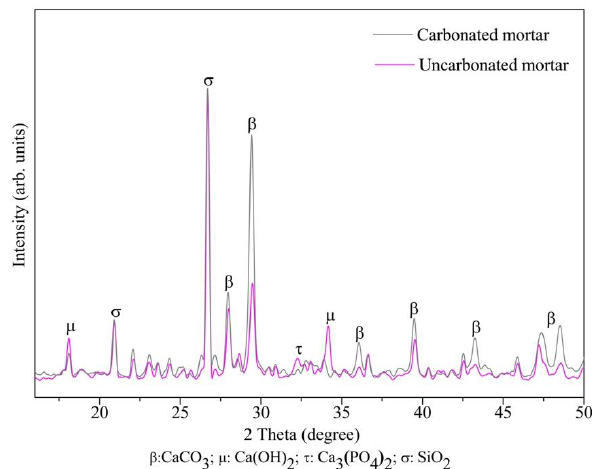
Figure 16. XRD patterns of carbonated (0% treated RFA) and uncarbonated (100% treated RFA) mortar.